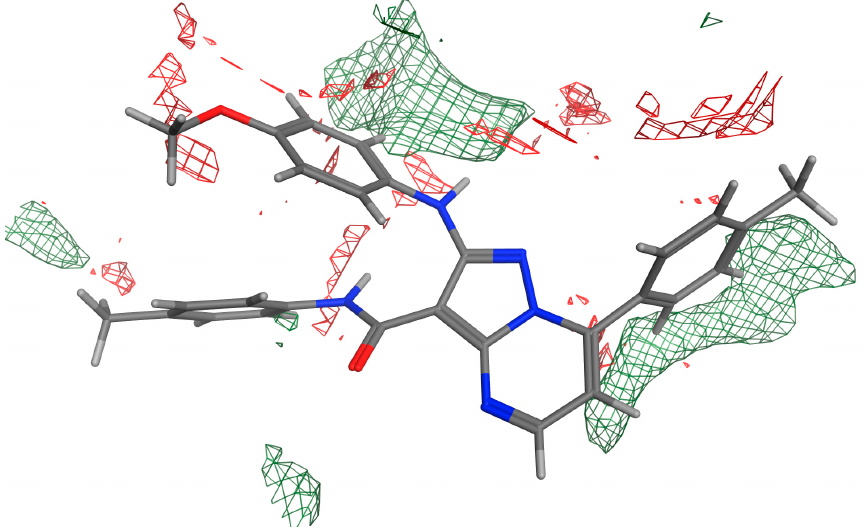
Figure 8. The electrostatic map of 13e shows the hydrophilic part (violet color) and the lipophilic part (blue color).